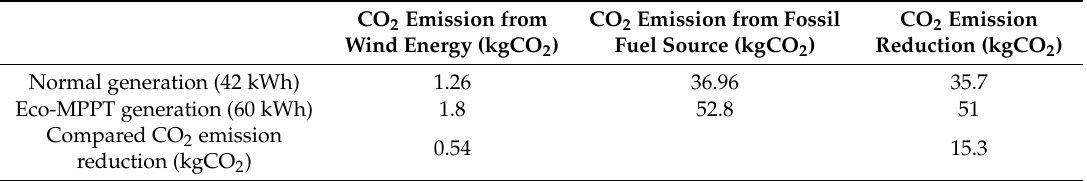
Table 3. The CO 2 emission and reduction in normal and Eco-MPPT cases compared to fossil fuel